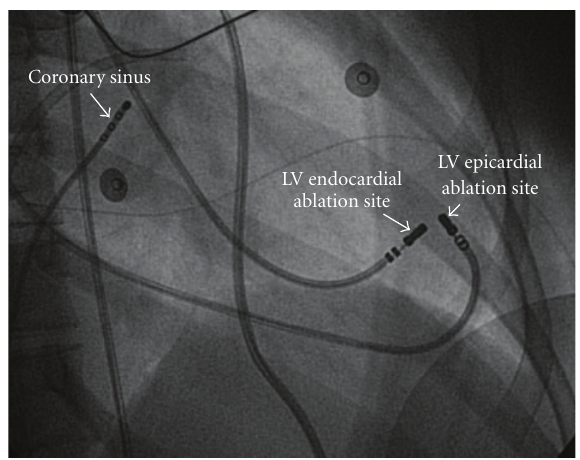
Figure 2: Fluoroscopic image showing the ablation catheters at the site of earliest activation endocardially and epicardially. The tip of the ablation catheters was located at the apicolateral side of the left ventricle. Ablation endocardially resulted in temporary elimination of the ectopy. Epicardially RF energy delivery was associated with phrenic nerve